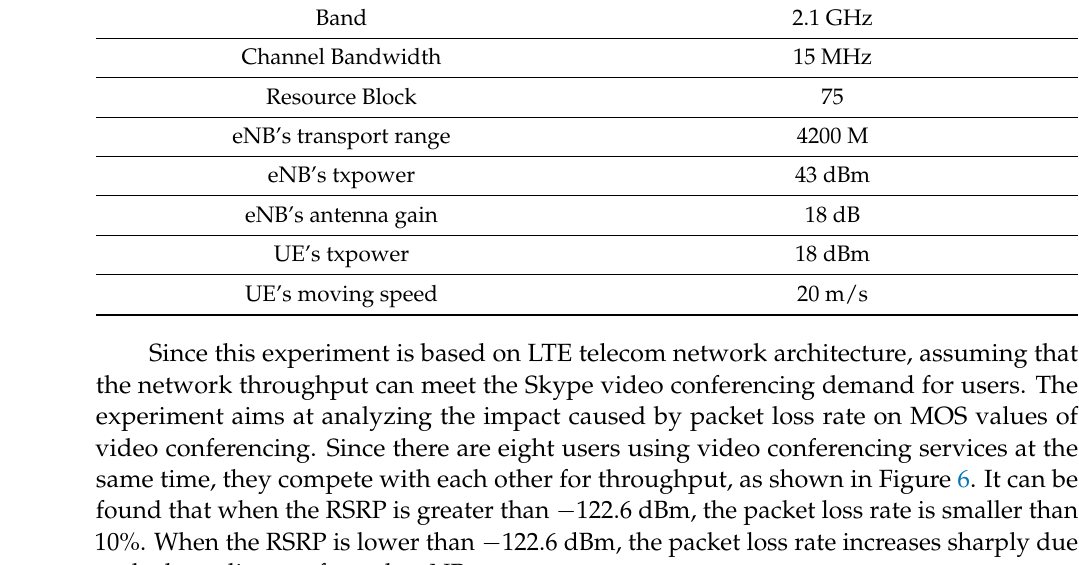
Table 4. The network parameters used in the simulation. Band